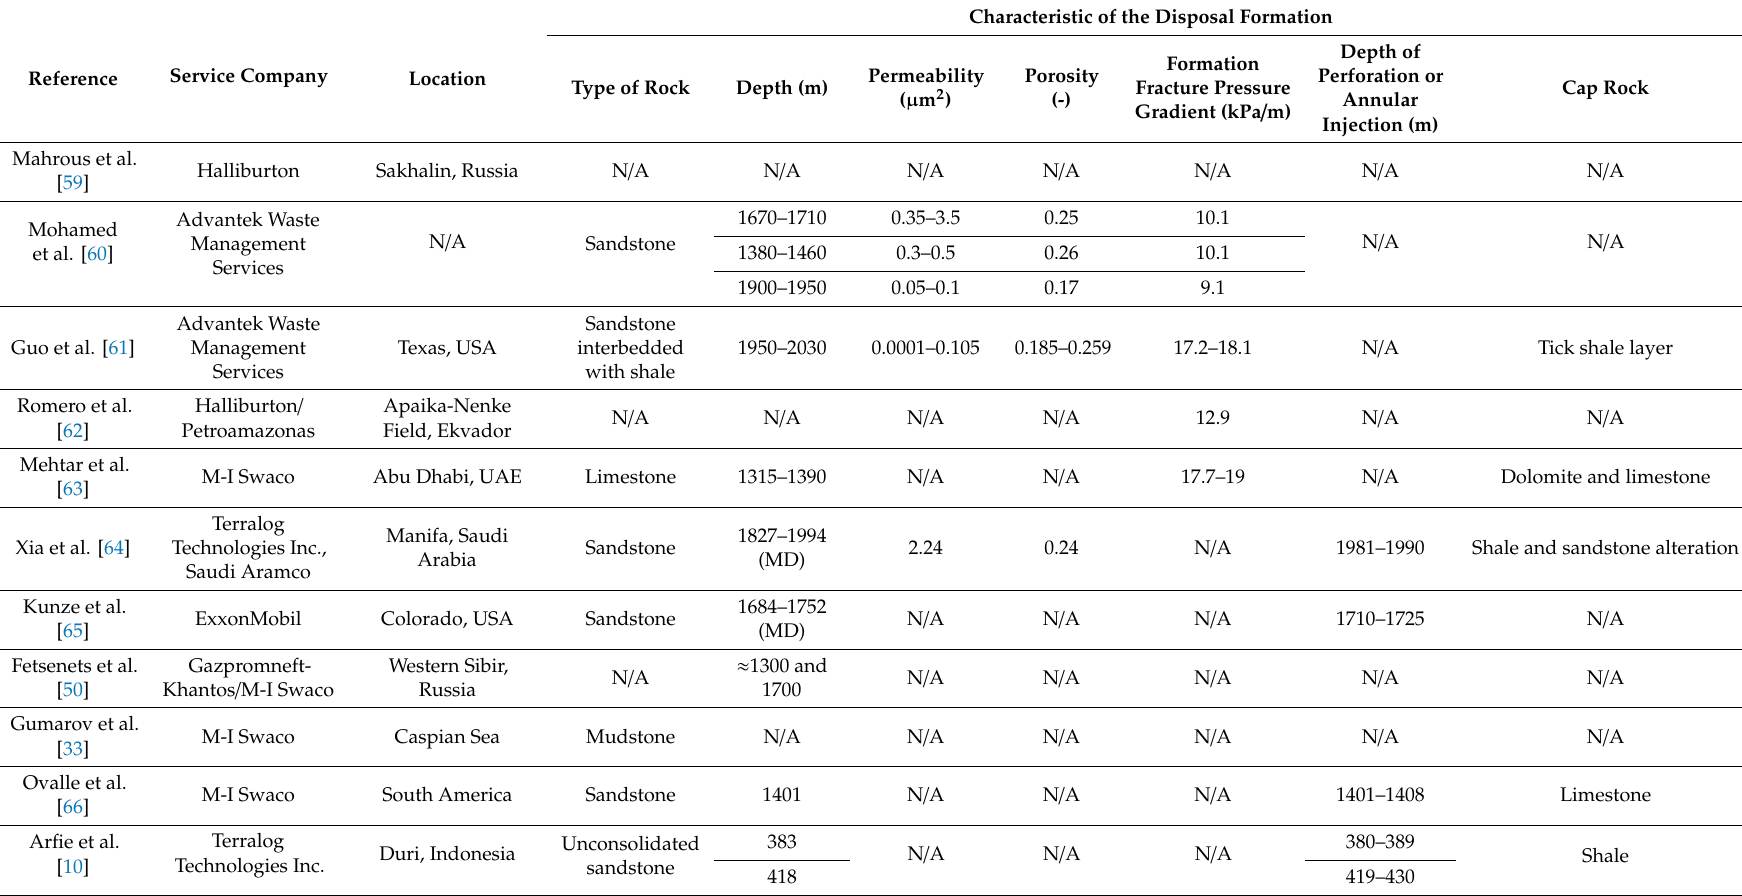
Table 7. Characteristics of the disposal